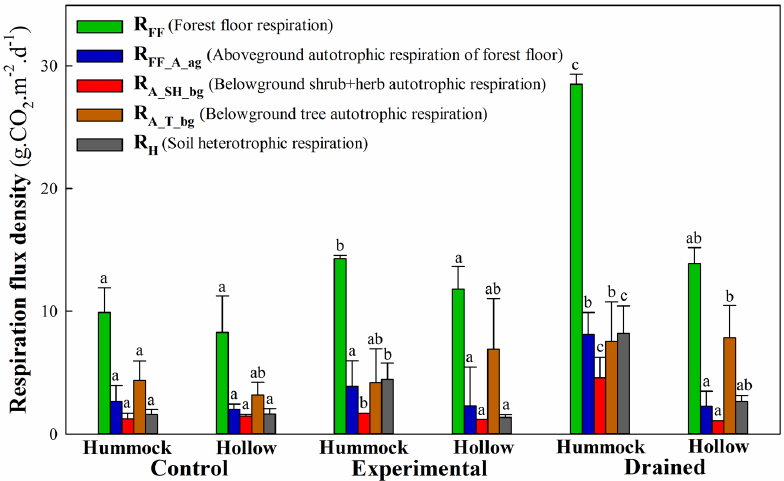
Figure 4. Mean (±SD) R FF , R FF_A_ag , R A_SH_bg , and R A_T_bg measured during the growing season (May to October) of 2012 at all sites/microforms. Mean R A_SH_bg was determined by using a biomass regression method (Tables 3 and 4; Figure 5) [46,52]. Bars having no letters in common are significantly different ( p < 0.05) while bars with same letters indicate no significant difference ( p > 0.05); letters should be compared only within one flux component across all microforms.